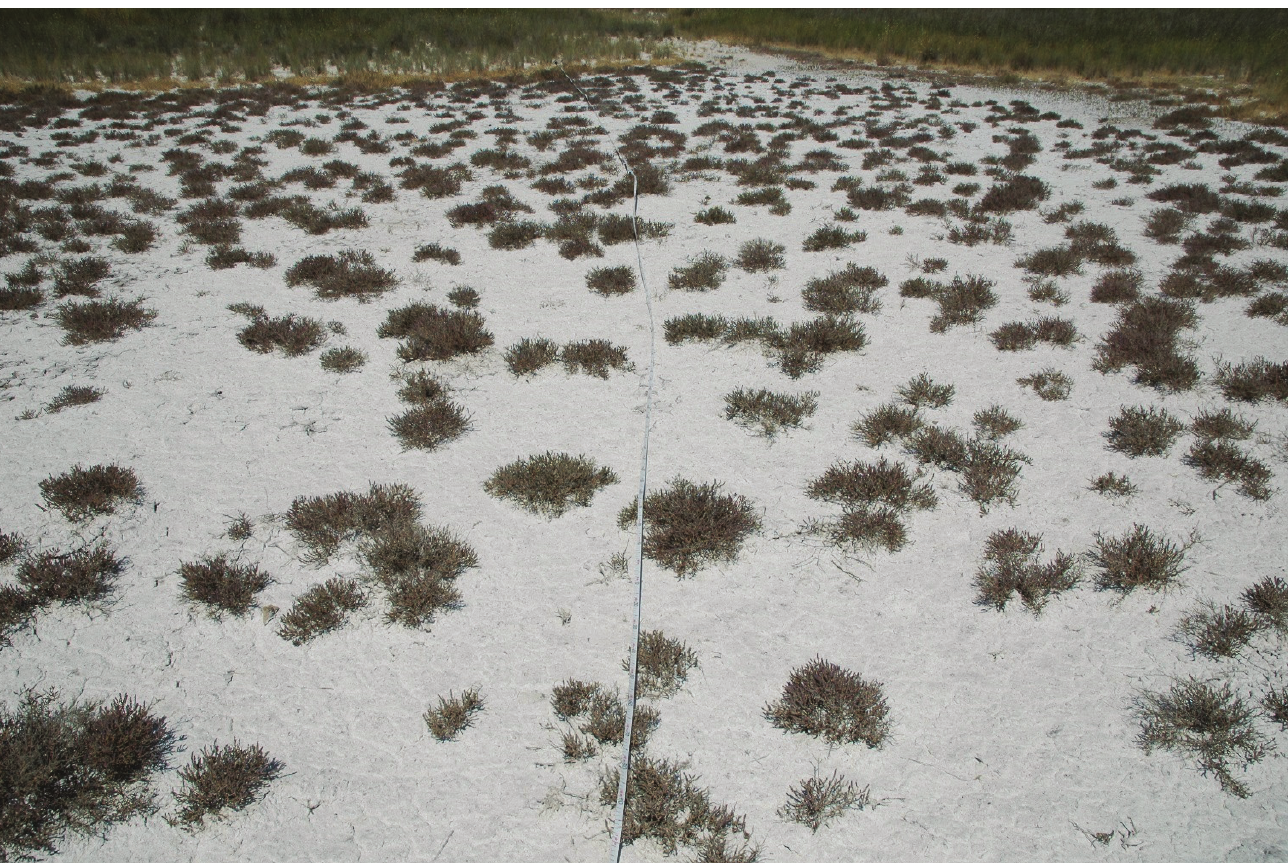
Fig. 2. Alkali seepweed prairie ( Suaeda vera ) without grazing, typical habitat of Mioscirtus wagneri in the study area (Peña Hueca lagoon, Villacañas, Toledo province, Spain). Photo by P.J. Cordero.